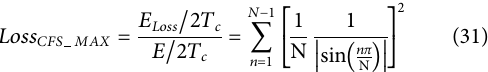
FIGURE 11 CNR loss under different